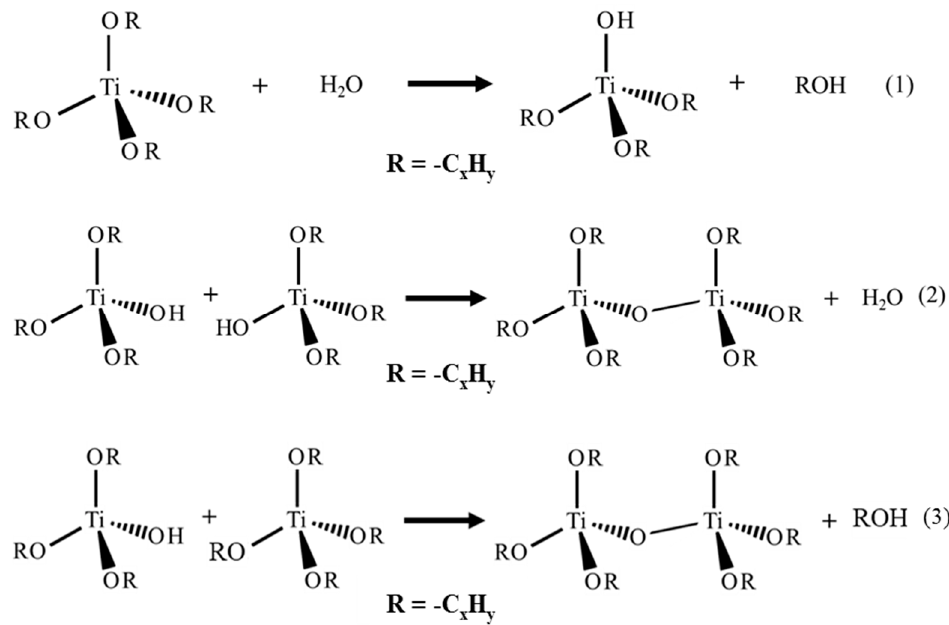
Figure 2. Hydrolysis and condensation reactions of the sol–gel process with Ti alkoxide precursor.